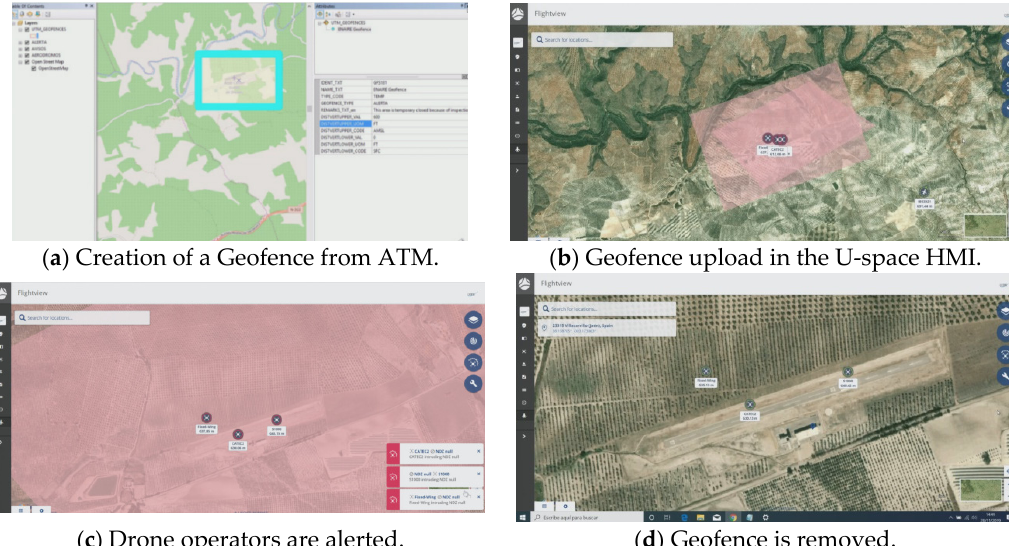
Figure 11. Illustration of the steps followed in the first scenario where the proposed procedure was that the crew informed ATM about the intent to operate in VLL airspace and the expected area of operation. In this case, the ATCos’ predefined action consists of creating a temporary geofence that covers the entire zone where the manned aircraft is operating.